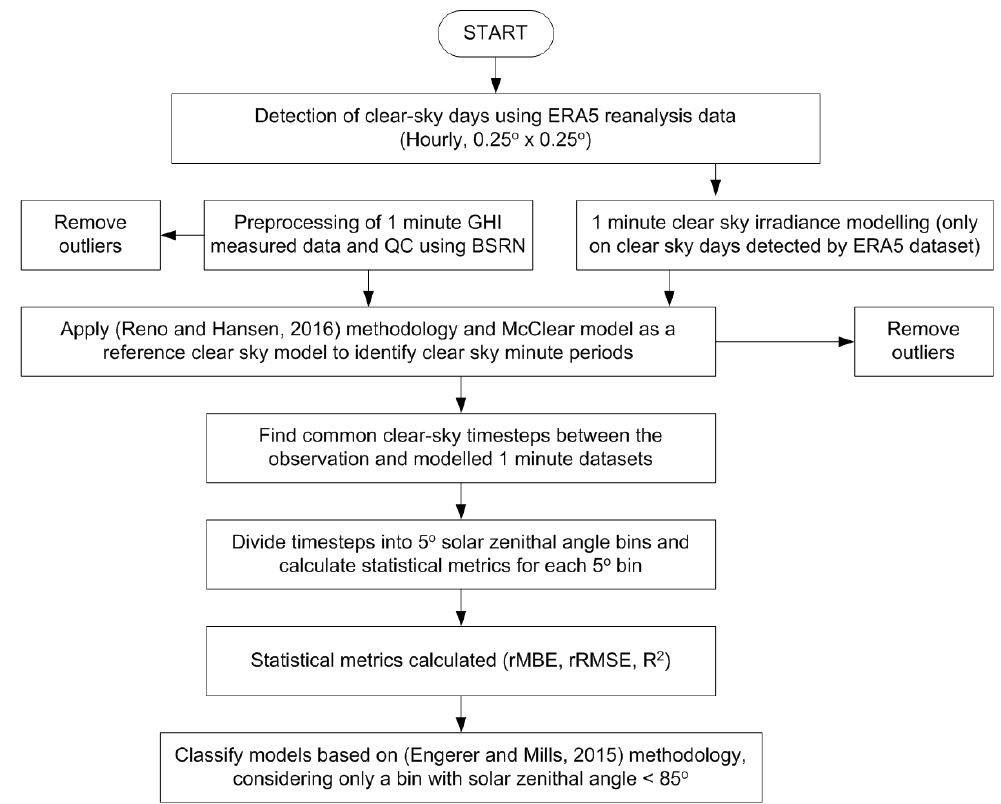
Figure 2. The flowchart of the approach summarising the methodology from clear sky detection to model classification based on their performance. {Fifth generation European Centre for Medium-Range Weather Forecasts atmospheric reanalysis (ERA5); Global horizontal irradiance (GHI); Quality control (QC); Baseline Surface Radiation Network (BSRN)}.